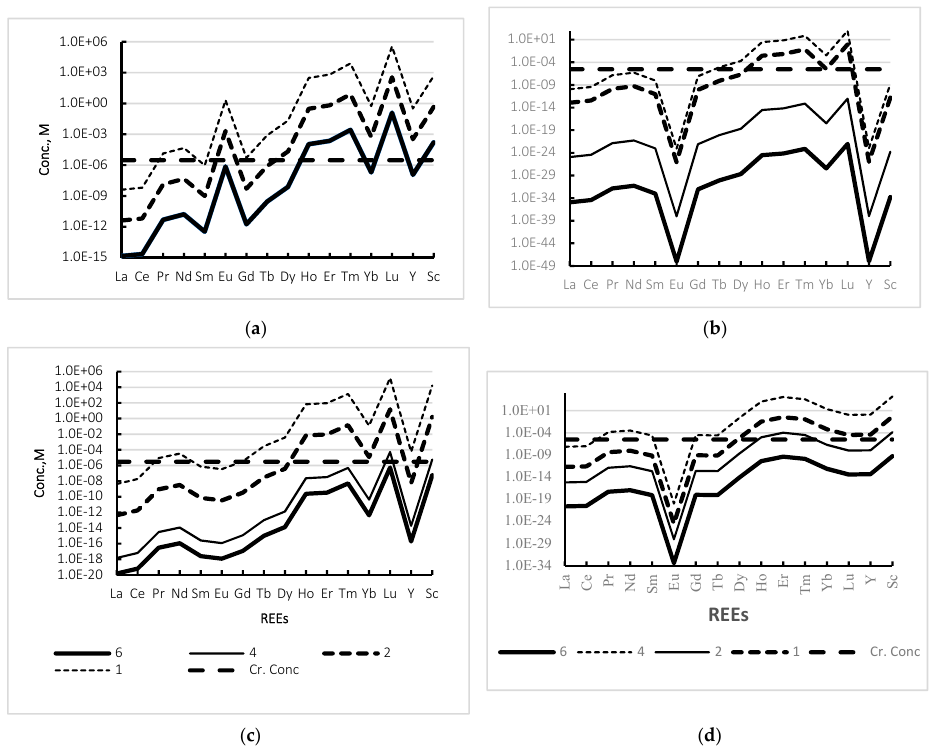
Figure 2. Concentrations of ( a ) Re 3+ , ( b ) ReCl 2+ , ( c ) Re(NO 3 ) 2+ , and ( d ) Re(SO 4 ) 2 − in equilibrium with fluoride precipitate with 10 − 4 M of total concentration of fluoride in solution at pH 6, 4, 2, and 1. Cr. Concentration: 1 ppm line as a target concentration.